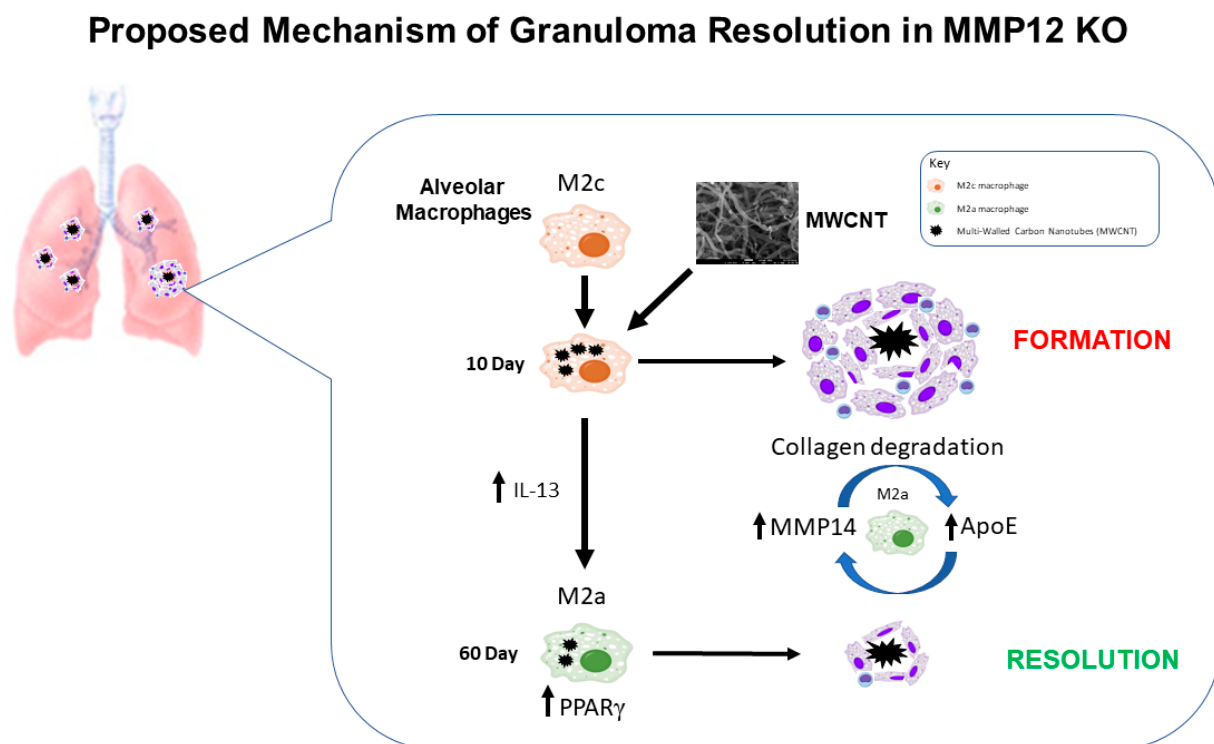
Figure 7. Schematic representation of the proposed mechanism. In Mmp12 KO mice, M2c macrophages are the predominant immune cell. In the presence of MWCNT, granulomas form at 10 days in the Mmp12 KO mice. An increase in IL-13 leads to the predominance of the M2a macrophage in MWCNT-instilled Mmp12 KO mice at 60 days. This shift in M2 macrophage phenotype correlates with the resolution of granulomas at 60 days in Mmp12 KO mice. We theorize that the role of M2a macrophages in granuloma resolution is through increased MMP14 surface expression which will function to degrade collagen, a defining feature of mature granulomas. These M2a cells also secrete increased ApoE, which can bind to collagen fragments, marking them for uptake. Through this collagen degradation and uptake, the stability of the granuloma will be diminished, leading to granuloma resolution.